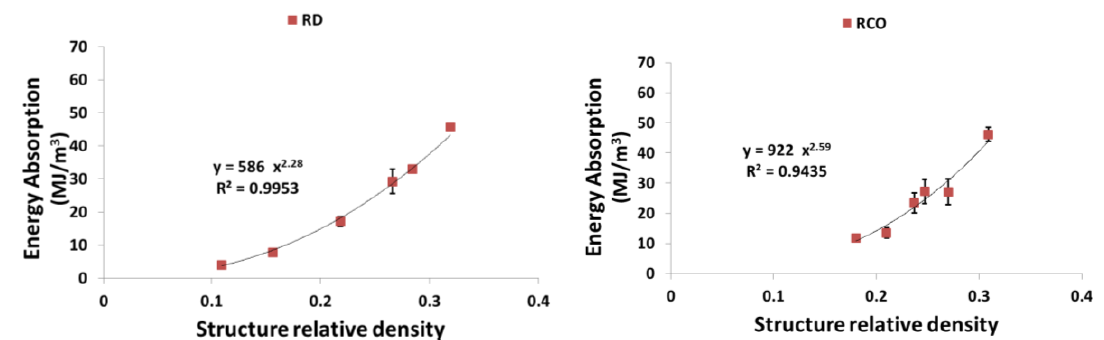
Figure 13. Summary of the energy absorption results for porous structures based on different types of unit cell configurations (cubic (C); diamond (D); truncated cube (TC); truncated cuboctahedron (TCO); rhombic dodecahedron (RD); rhombicuboctahedron (RCO)) and different structure relative densities (see Table